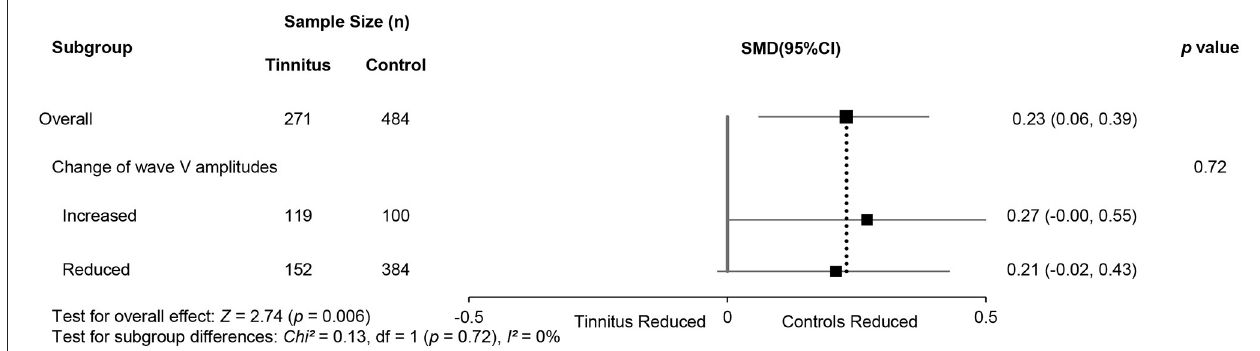
FIGURE 6 | Subgroup analysis of the relationship (95% CI) between wave V/I ratios and changes in wave V amplitudes.